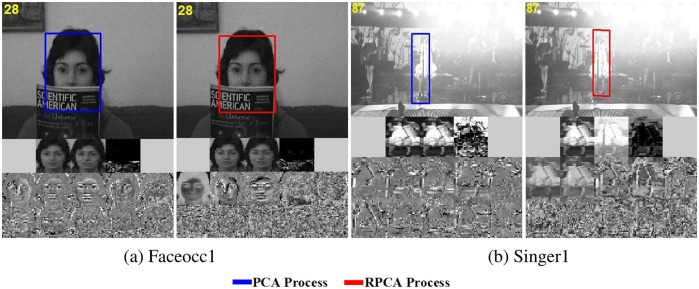
Comparison of PCA and RPCA.The upper portion of the image is the tracking frame. the middle of the image consists of three sub-pictures, the left is the mean image, the middle is the reconstruction result, and the right is the Lapalace noise. the bottom of the image is the top ten basis vectors of dictionary. (a) shows the tracking results of PCA and RPCA dictionary initialization. The tracking performance with and without RPCA reinitialization is shown in (b). Reprinted from [20] under a CC BY license, with permission from Yi Wu, original copyright 2013.